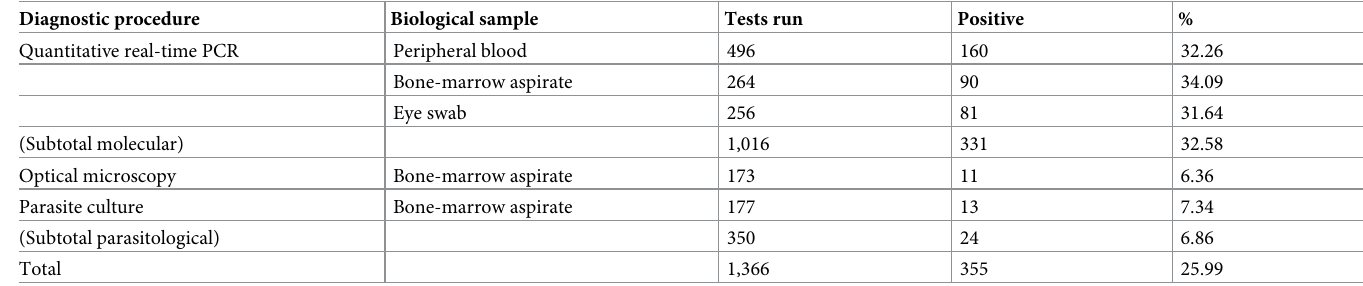
Table 4. Detecting Leishmania in dogs from central-western Brazil: Summary of test results stratified by diagnostic procedure and biological sample. Diagnostic